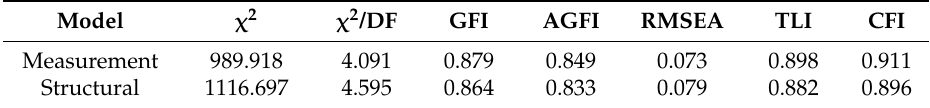
Table 4. Goodness-of-fit indexes for measurement and structural